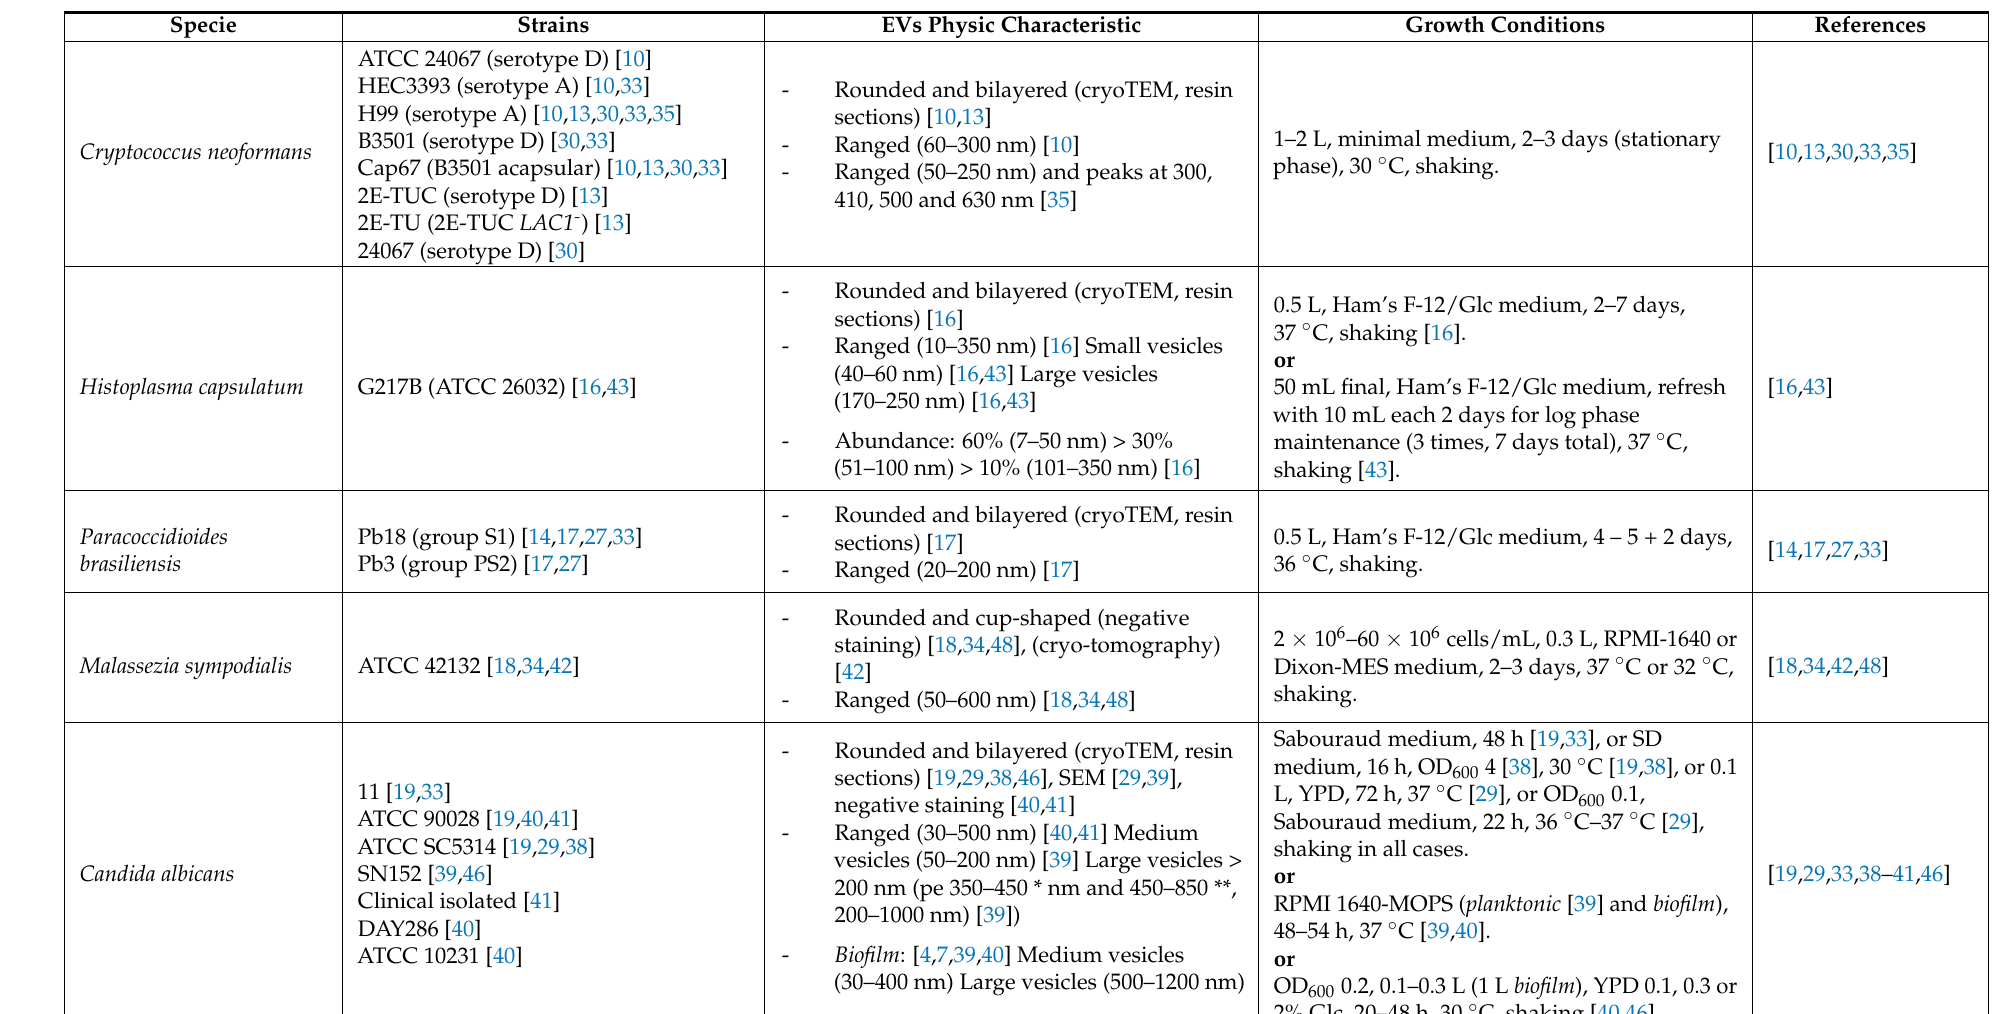
Table 3. Morphology and profile of fungal